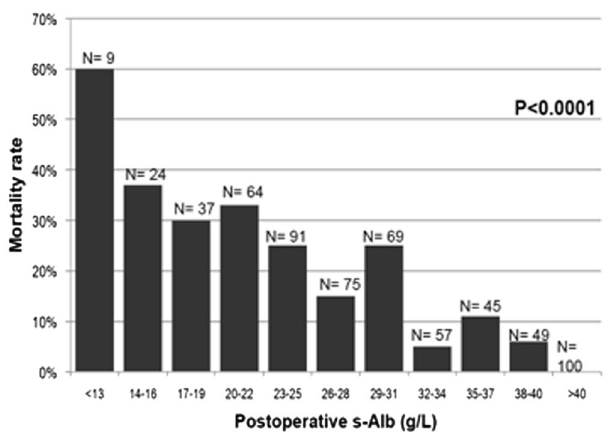
Figure 2. Association between all-cause mortality within one year of surgery and postoperative albumin concentrations.